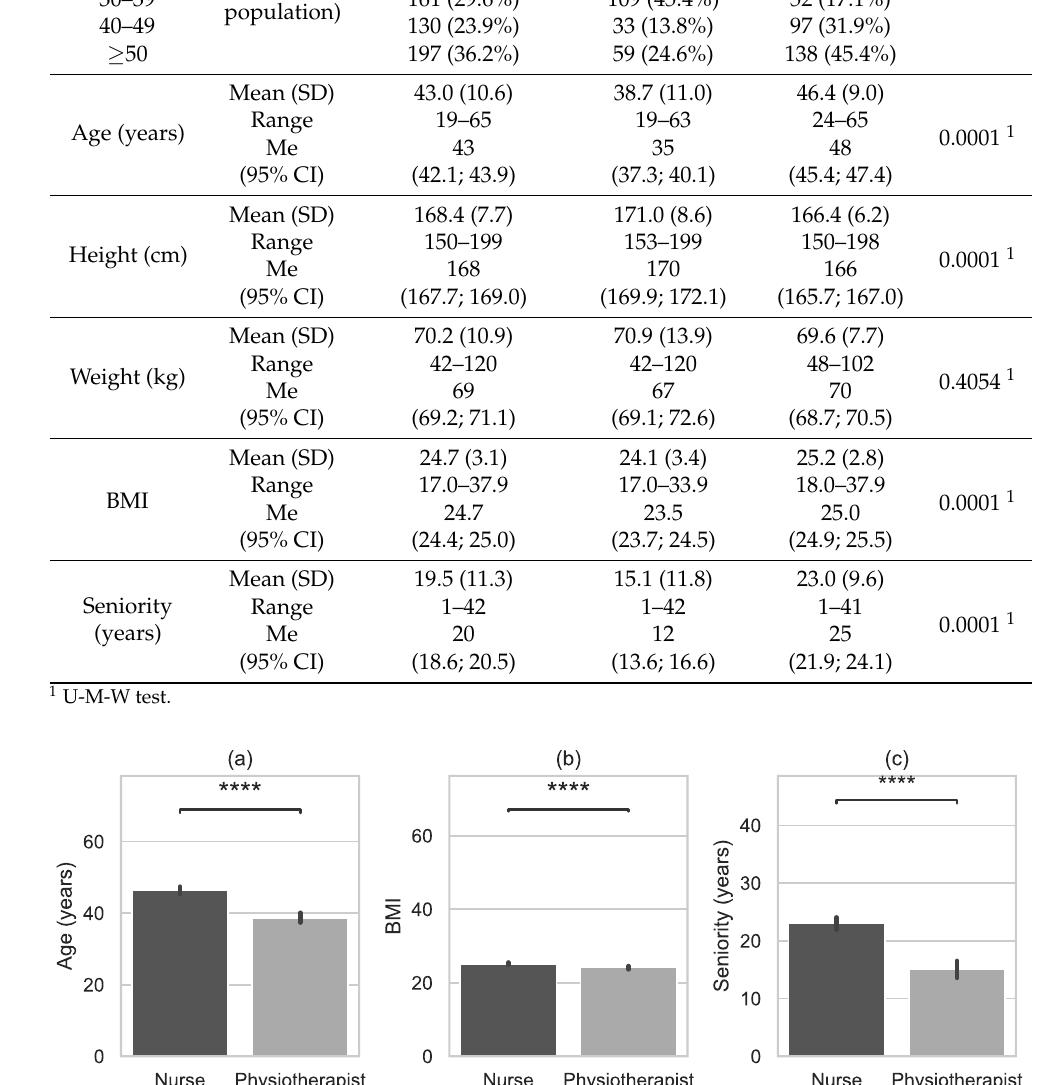
Figure 1. Characteristics of examined groups (occupation) with error bars and p -value annotation legends: ( a ) Age, ( b ) Body Mass Index (BMI), ( c ) Seniority (working years in occupation). ns: 5.00e- 02 < p <= 1.00e + 00; *: 1.00e-02 < p <= 5.00e-02; **: 1.00e-03 < p <= 1.00e-02; ***: 1.00e-04 < p <= 1.00e- 03; ****: p <= 1.00e-04.